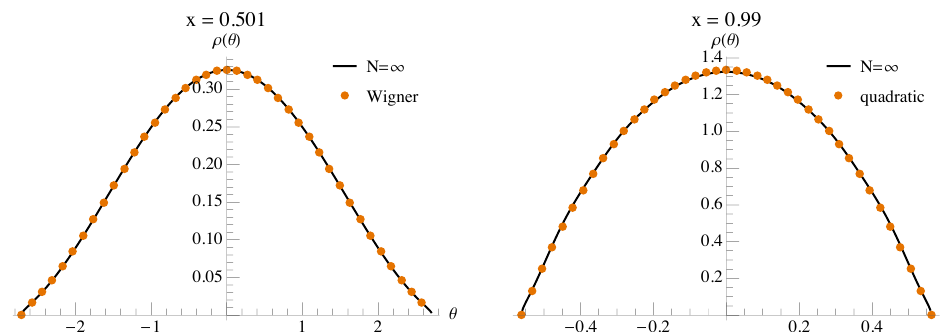
Figure 3 . Temperature dependence of the phase density (cid:26) ( # ; x ). Left: just above the Hagedorn transition. The black line is the density obtained by plugging in (2.8) the solution of (2.10). The orange points are sample evaluations of (2.12) and superimpose quite well. Right: near x = 1. Again, the black line is the result from the self-consistent algorithm, while the orange points are samples of (2.13). Apart from the very ends of the distribution, the agreement is very good. as will also be con(cid:12)rmed analytically in the next